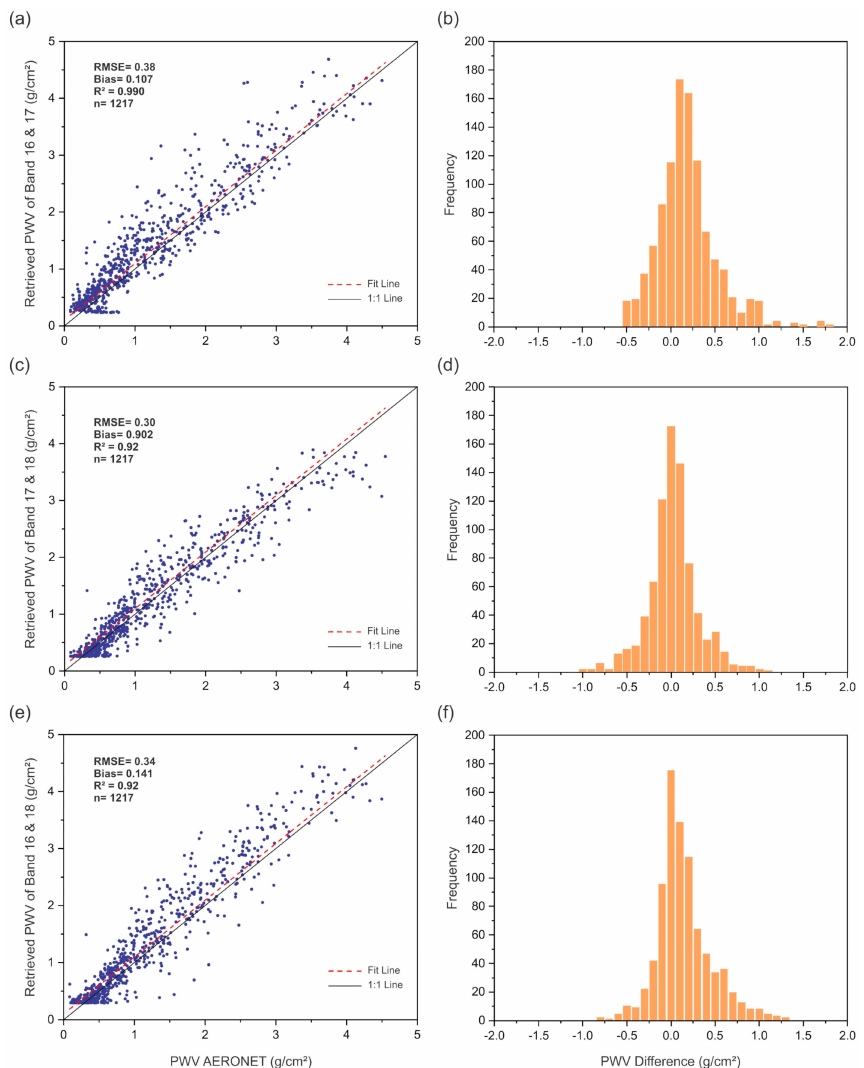
Figure 9. Scatterplots show retrieved PWV values. ( a , b ) Band 16 with band 17, ( c , d ) band 17 with band 18 and ( e , f ) band 16 with band 18 versus ground-based sun-photometer